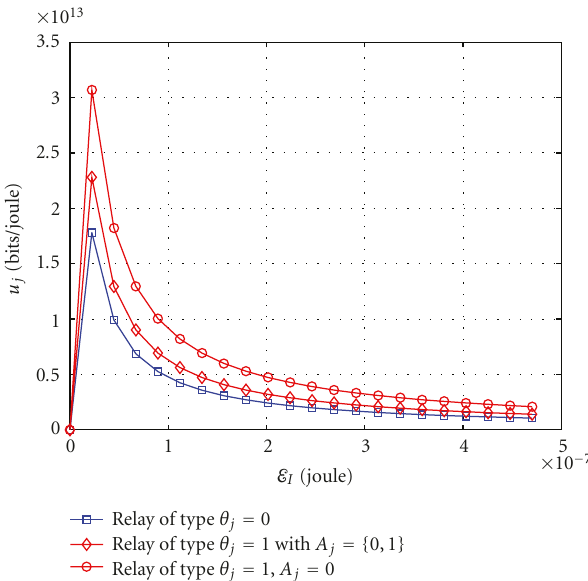
Figure 11: Utility relay terminal j as a function of total energy expended for cooperative transmission of information bearing signal. It is evident that a selfish terminal can exploit the cooperative behavior of its partners to maximize its